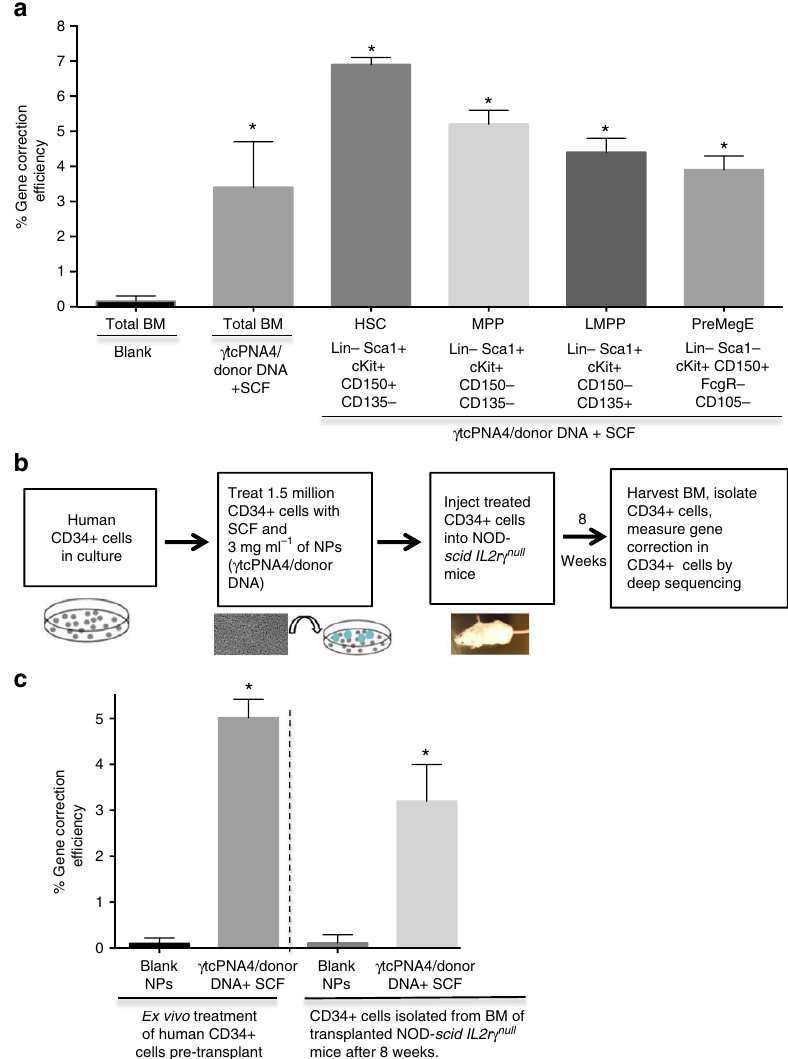
Figure 5 | Gene editing in mouse BM stem cell populations in vivo and human CD34 þ cells ex vivo. ( a ) Thalassemic mice were treated with either blank NPs or NPs containing g tcPNA4/donor DNA plus SCF (four doses at 2-day intervals as in Fig. 4). Deep sequencing analysis was performed to measure gene editing in the b -globin gene in either total BM (total BM) cells or in BM stem/progenitor cell sub-populations selected based on the indicated markers. BM cells were harvested either on day 36 post-treatment (total BM samples) or on day 65 post-treatment (sorted cell sub-populations). Data represent the combined analysis of BM from n ¼ 3 mice in each group. Data are mean ± s.e.m., n ¼ 3; statistical analysis by Student’s t -test, * P o 0.05. ( b ) Schematic showing experimental design in which human CD34 þ cells were treated ex vivo with either blank NPs or with g tcPNA4/donor DNA NPs plus SCF. Treated cells were either harvested 2 days later for deep sequencing analysis of gene editing in the b -globin gene or were transplanted into NOD- scid IL2r g null mice. Eight weeks after transplantation, BM cells were harvested from the mice and human CD34 þ cells were isolated, followed by deep sequencing of the the b -globin gene alleles. ( c ) Deep sequencing results to quantify b -globin gene editing in either pre-transplanted human CD34 þ cells or in human CD34 þ cells that were harvested from NOD- scid IL2r g null mice 8 weeks after transplant, as described in b . Data are mean ± s.e.m., n ¼ 3 statistical analysis by Student’s t -test, * P o